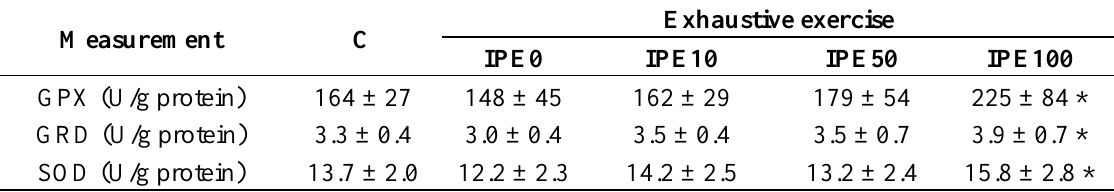
Table 2. Effect of I. parviflora extract (IPE) supplementation on hepatic antioxidant enzyme activities after an exhaustive swimming exercise